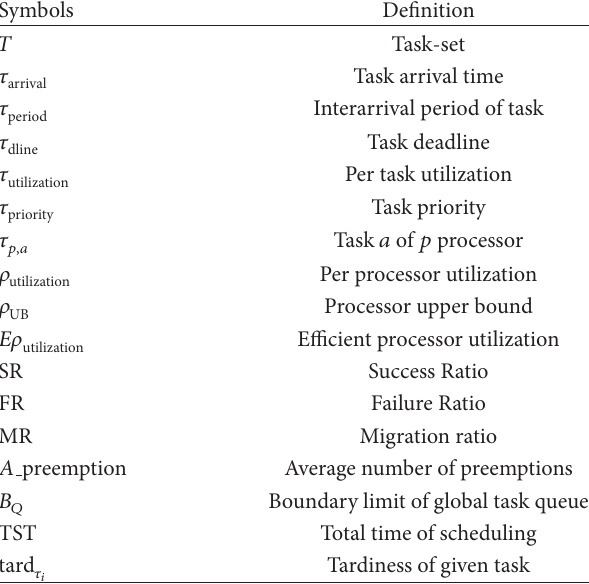
Table 1: Symbols and